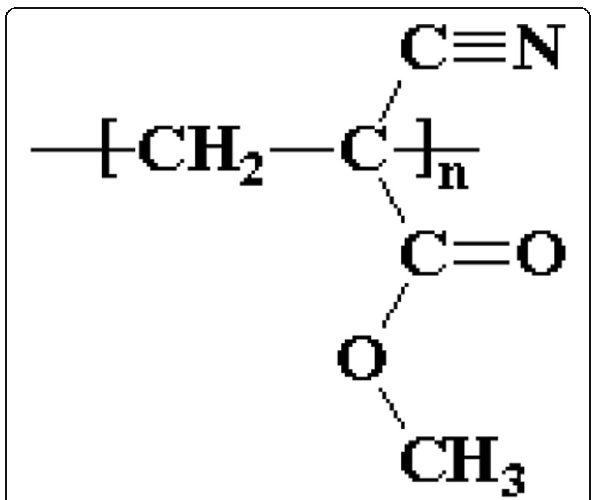
Fig. 2 Chemical structure of Polymerized Ethyl Cyanoacrylate